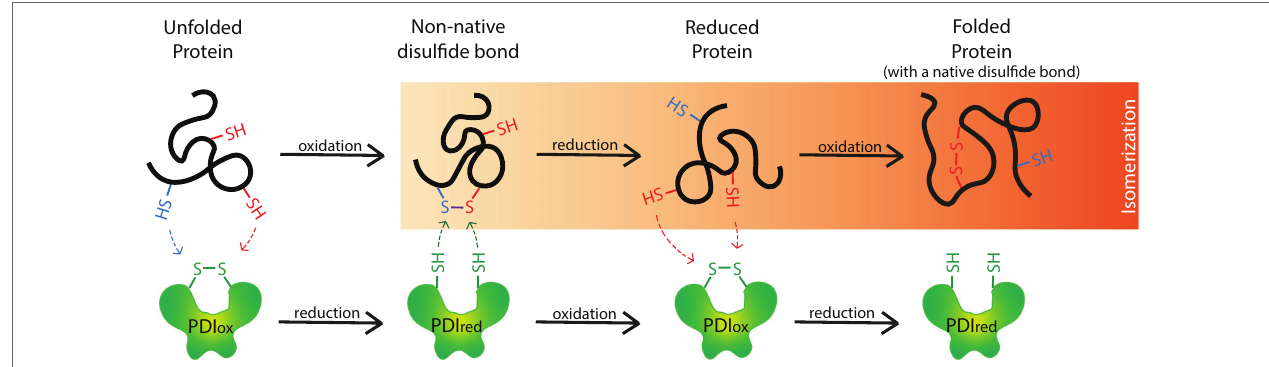
FIGURE 3 | Protein disulfide isomerases (PDIs) form disulfide bridges that assist in the proper folding of proteins. PDIs (PDIox) oxidize thiol/sulfhydryl (–SH) side chains on unfolded proteins to form disulfide bonds (S–S) and are thereby reduced (PDIred). S–Ss often form between incorrect thiols (i.e., blue-SH with a red-SH) to form non-native S–Ss. When this occurs, the S–S undergoes isomerization whereby non-native S–Ss are reduced back to-SHs by a PDIred. A PDIox then oxidizes the correct-SHs (i.e., 2 red-SHs) on the reduced protein to form the correct native S–S and produce a properly folded